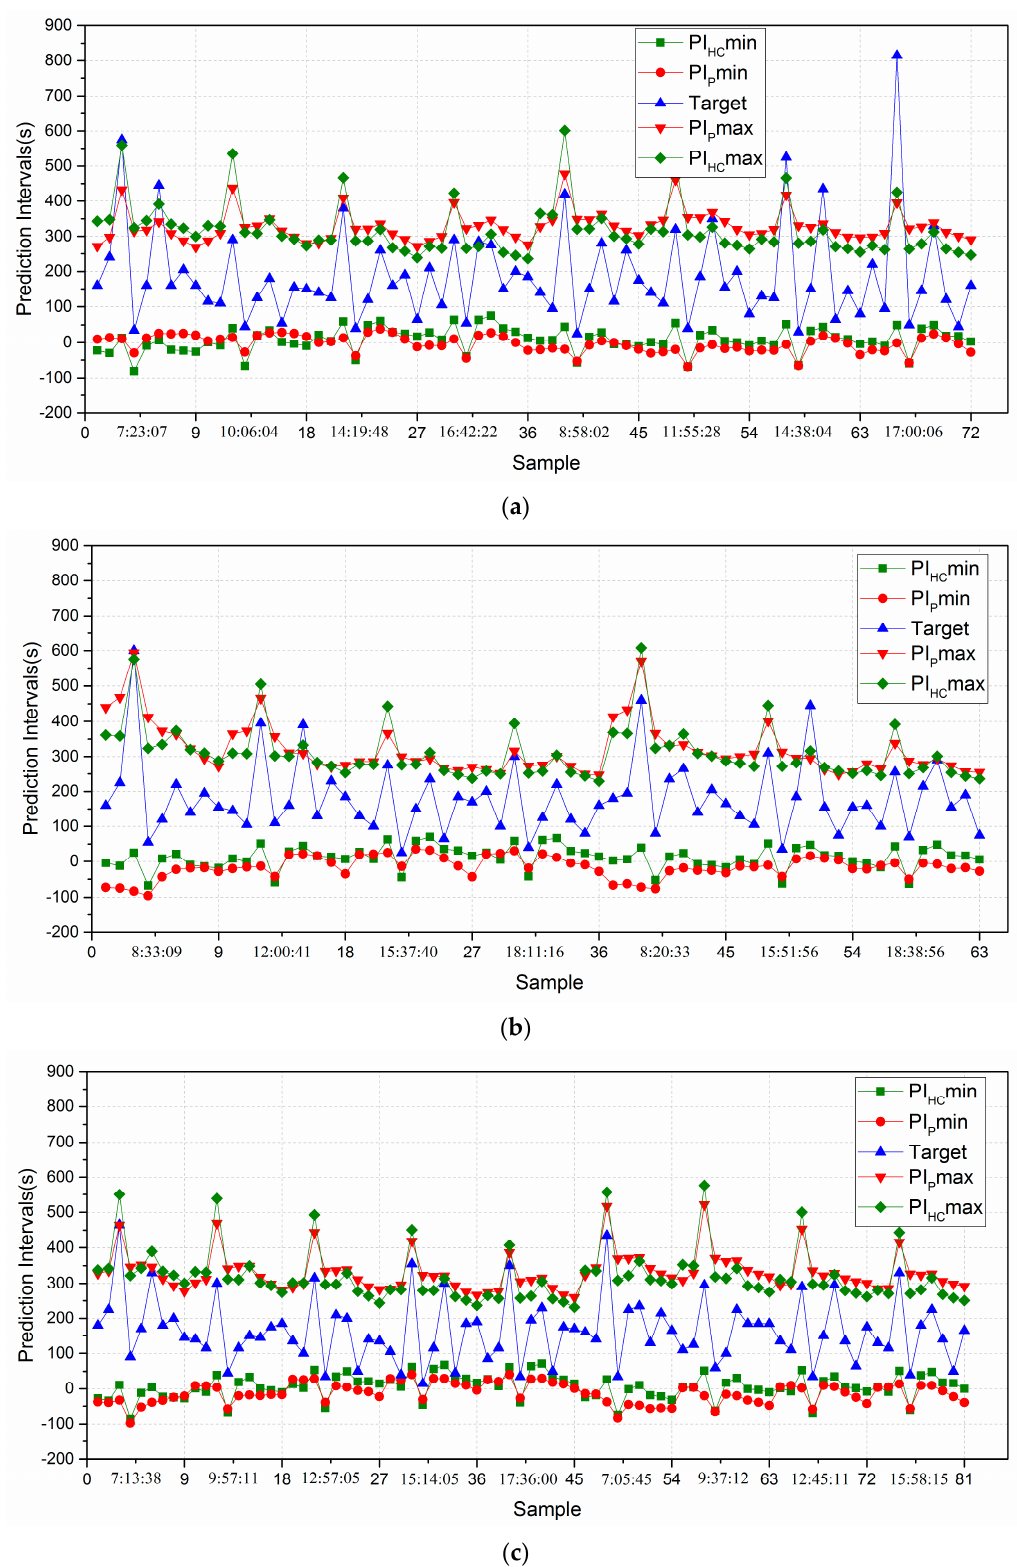
Figure 7. PI results at 90% confidence level: ( a ) PI HC and PI P for 902335; ( b ) PI HC and PI P for 902353; ( c ) PI HC and PI P for